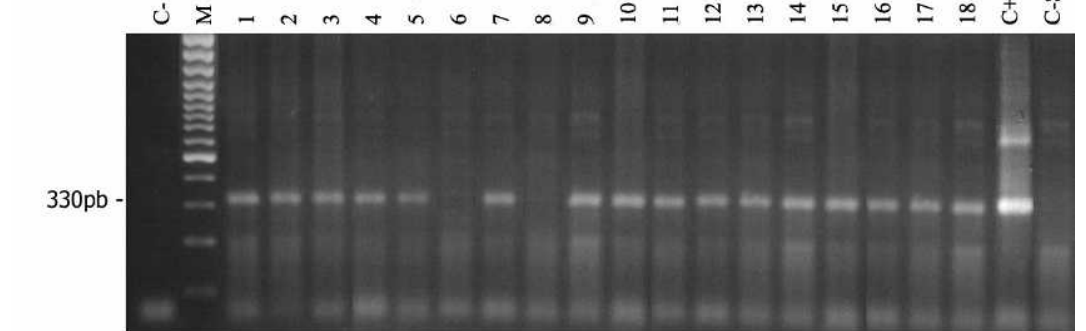
Fig. 1. – Electrophoretic pattern of the 330 bp minicircle region of T. cruzi kDNA-PCR amplified with primers 121 and 122 from different human subjects and stained with ethidium